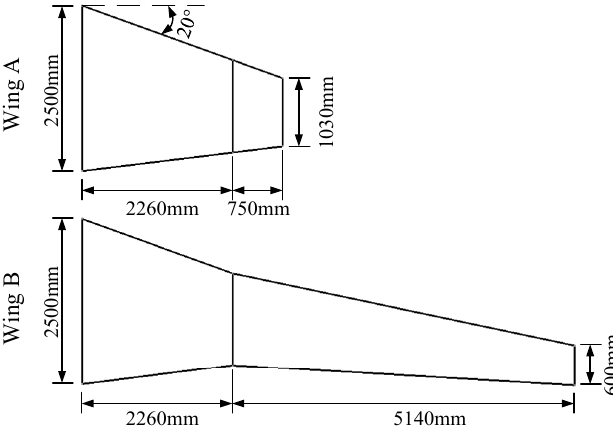
Figure 5. The shape of the modular wing.